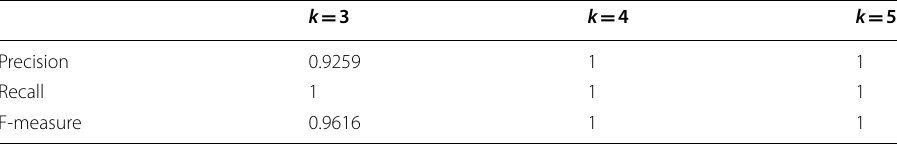
Table 17 Performance of PDSM in detecting near-duplicate documents (R8_NDD) k 3 k 4 k 5 = = = Precision 1 1 1 Recall 1 1 1 F-measure 1 1 1